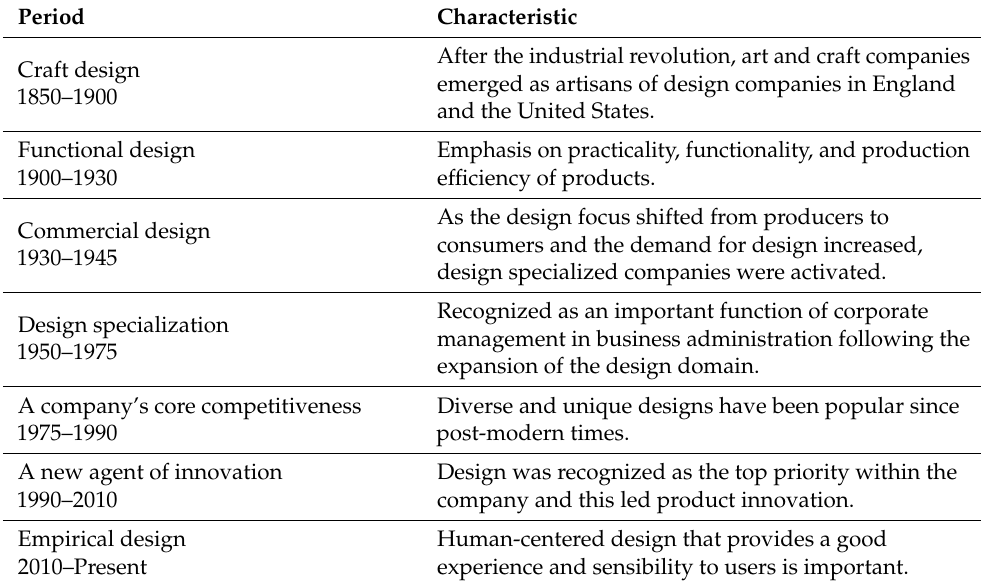
Table 4. Changing the meaning of